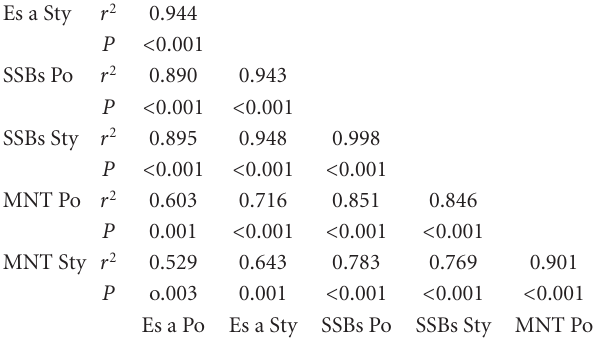
Table 1: Results of the regression between the cytological tests of samples from the young coral communities. Samples were collected from Stylophora pistillata (Sty) and Pocillopora damicornis (Po). In each square, the top figure is r 2 and the bottom is the P